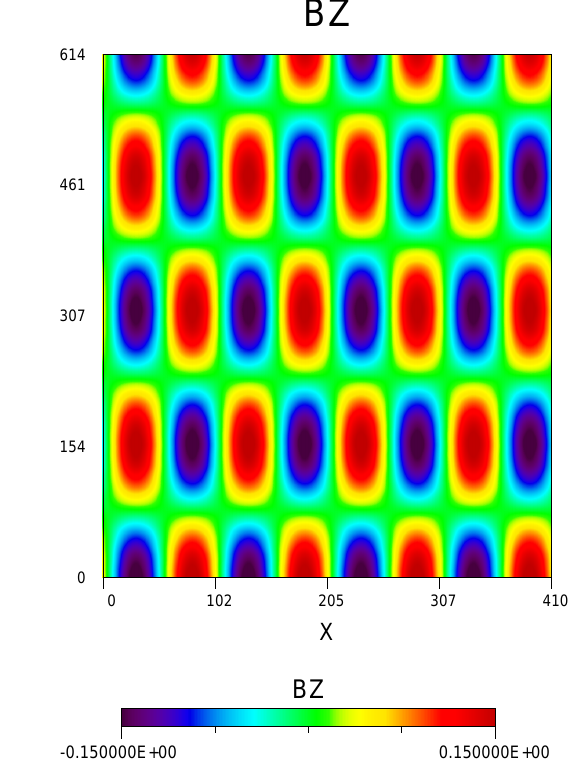
Fig. 3. AWC003 (a slower and a faster wave packets). Temporal stack plot of the longitudinal electric field E X (X,t) .